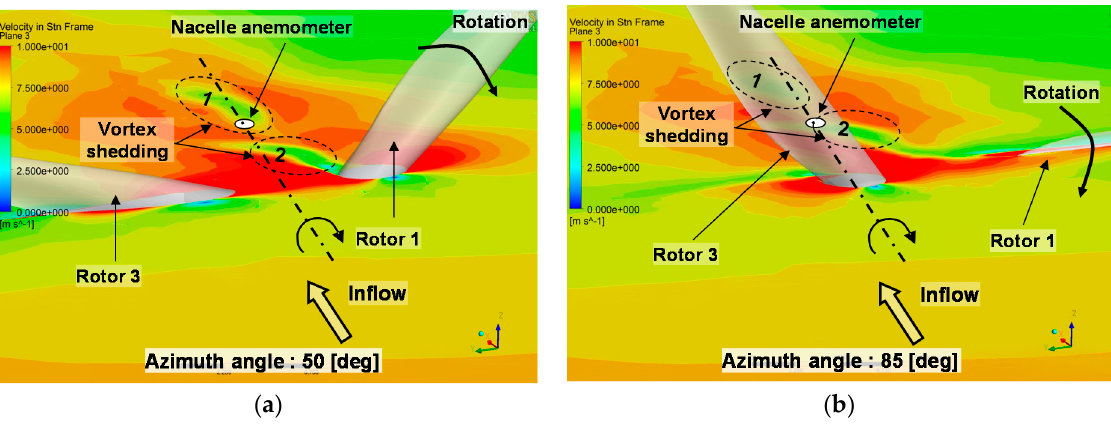
Figure 10. Velocity distribution around nacelle anemometer. ( a ) 50° azimuth angle, ( b ) 85° azimuth angle.